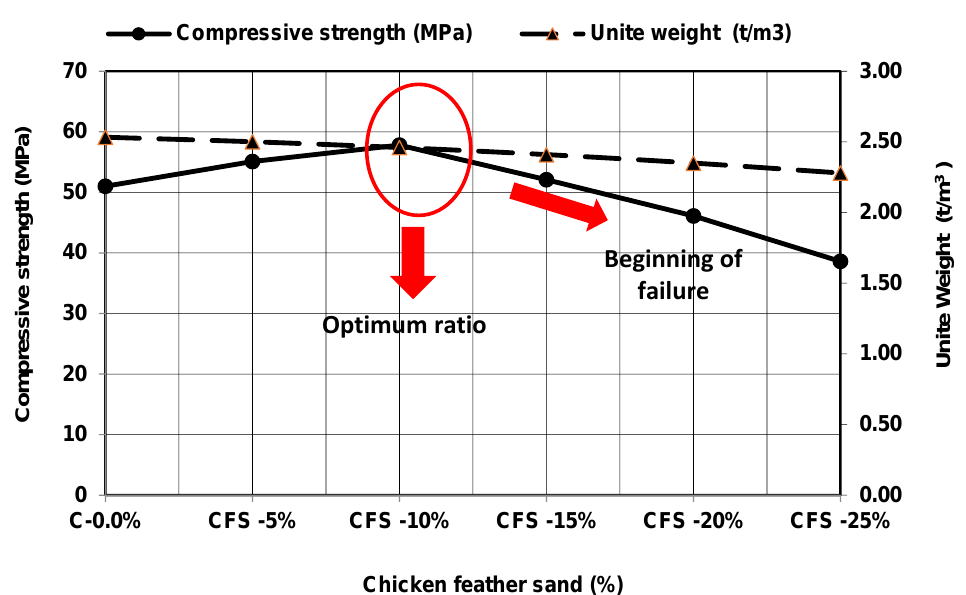
Figure 8. The relationship between compressive strength and unit weight depends on the replacement percentage.